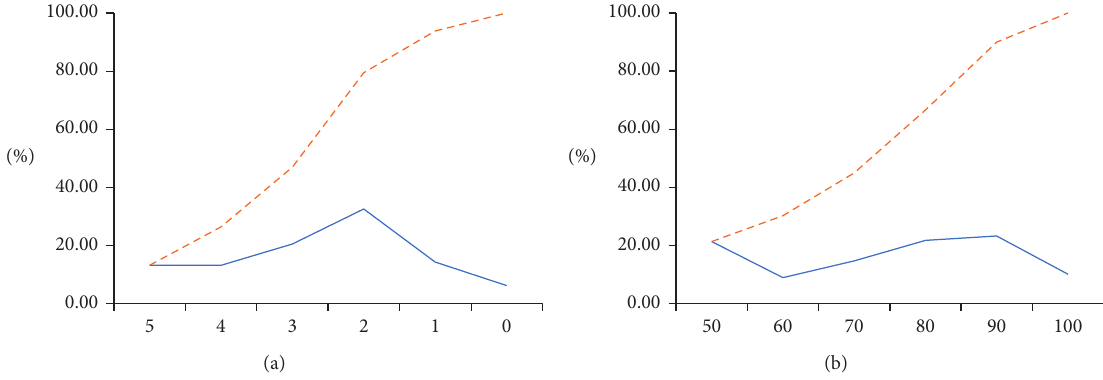
Figure 1: Distribution of the timing of VC entry in firms. (a) Distribution type 1. (b) Distribution type